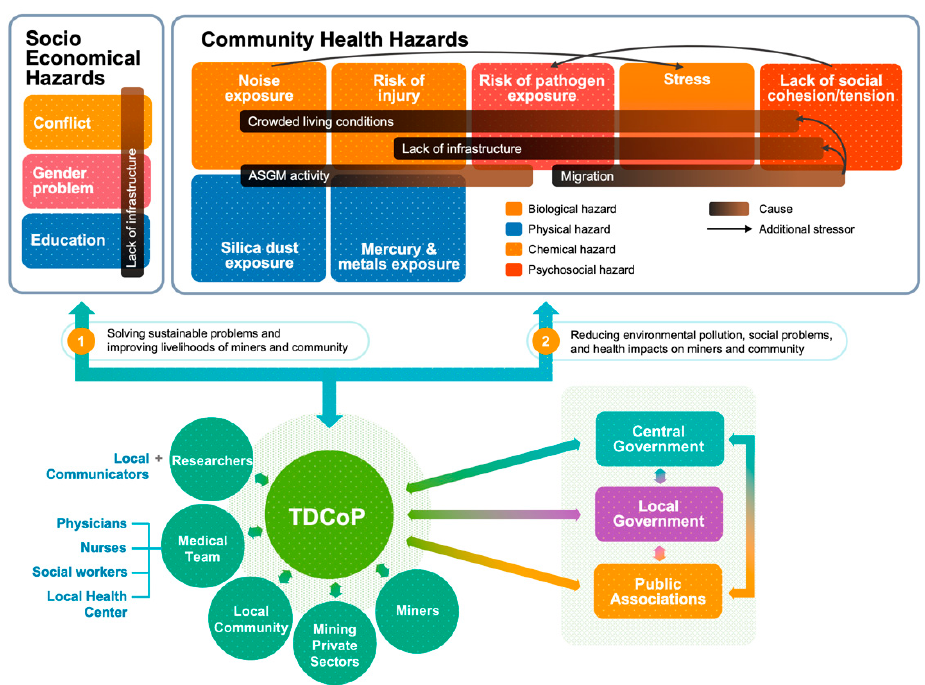
Figure 1. Transdisciplinary communities of practice (TDCoPs): a process to solve the wicked ASGM problems in SEA. Reproduced with permission from [69]. 2015, Basu N et al. The credit for the summary on the community health hazards goes to Basu N et al., 2015 “Integrated Assessment of Artisanal and Small-Scale Gold Mining in Ghana—Part 1: Human health Review”.